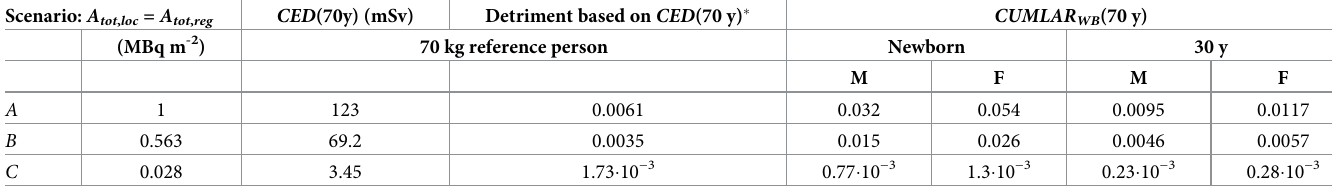
Table 6. Average individual detriment accumulated over 70 y for a resident living in an area affected by a Chernobyl-like NPP remote fallout for newborns and 30 y olds. Detriments are given in terms of cumulative effective dose, CED (70 y), attributed detriment using the ICRP (2007) risk coefficients for members of the public (0.05 Sv -1 ), and cumulative lifetime attributable risk of cancer (excluding non-fatal skin cancers) incidence, CUMLAR Table 5. Scenario: A tot , loc = A tot ,